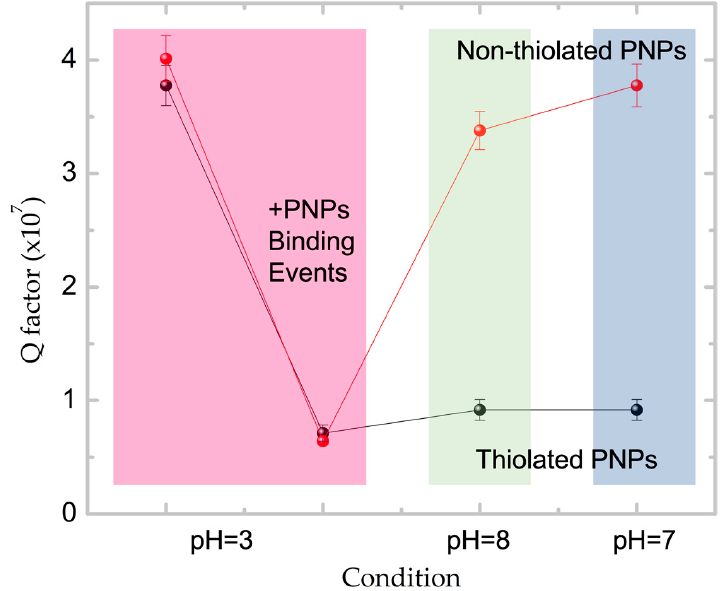
Figure 7. FWHM values corresponding to pH = 3 assembled sensors (both electrostatic (red) and covalent (black) binding) after exposure to aqueous solutions with pH = 8, showing different stabilities.